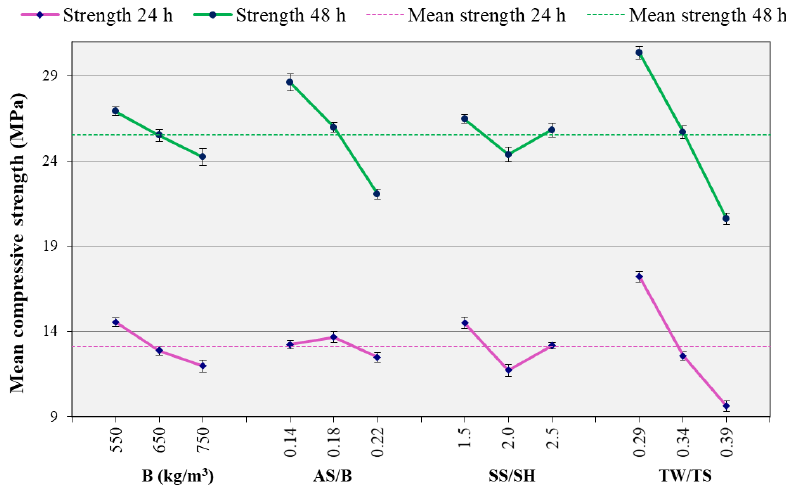
Figure 7 shows the effect of each of the studied parameters on the compressive strength. Each of the figure’s data points is obtained by taking the average of the compressive strengths for all the mixes containing that parameter as explained in Section 3.1.1. As shown in this figure, the main parameter that significantly affects the compressive strength is the TW/TS ratio. The increase of this ratio decreased both the 24 h and 48 h compressive strengths. The relationship is similar to that of OPC concrete’s strength to water to cement ratio relationship. Similarly, the binder content also affected the compressive strength, however, at a lower significance compared to TW/TS ratio. As for the AS/B ratio, the strength decreased significantly in the case of 48 h, but no significant change was observed at 24 h.